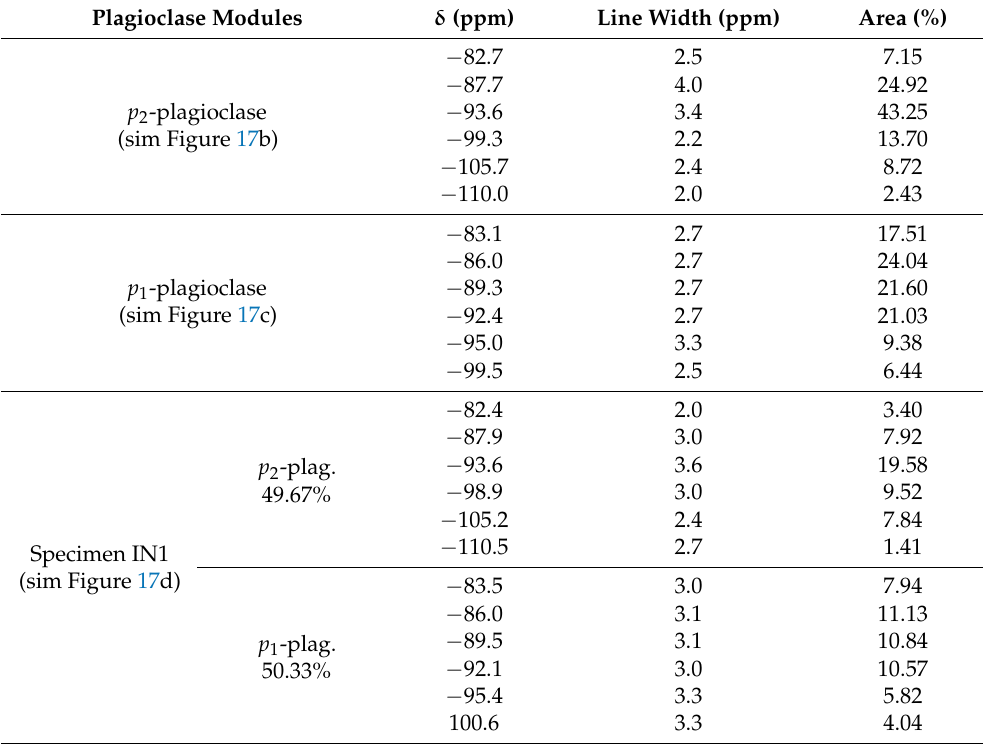
Table 7. Simulation of the 29 Si spectrum from the 27 Al{ 29 Si} HMQC NMR spectrum at 17.6 T of specimen IN1 of labradorite An 50 (Figure